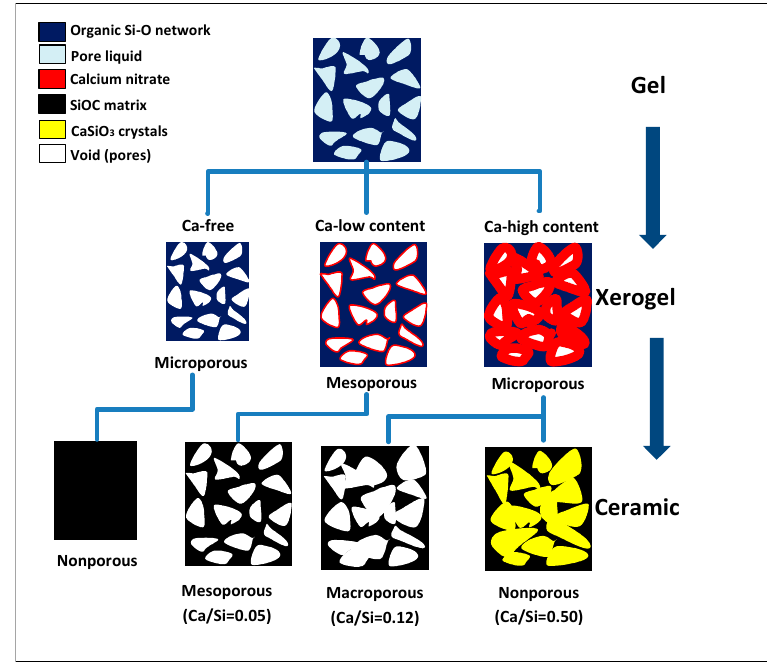
Figure 7. SEM surface morphology analysis of ( a ) SiCa0, ( b ) SiCa5, ( c ) SiCa12, and ( d ) SiCa50.